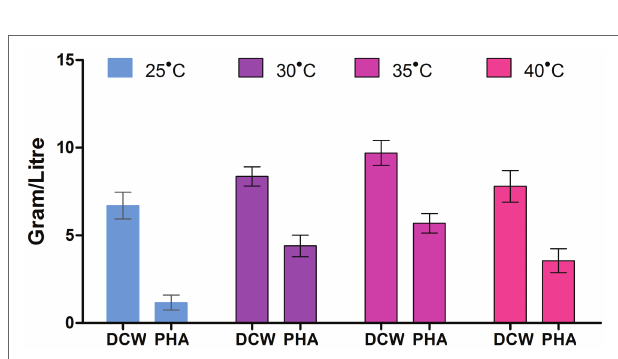
FIGURE 4 | Effect of temperature on PHA production by P. aeruginosa